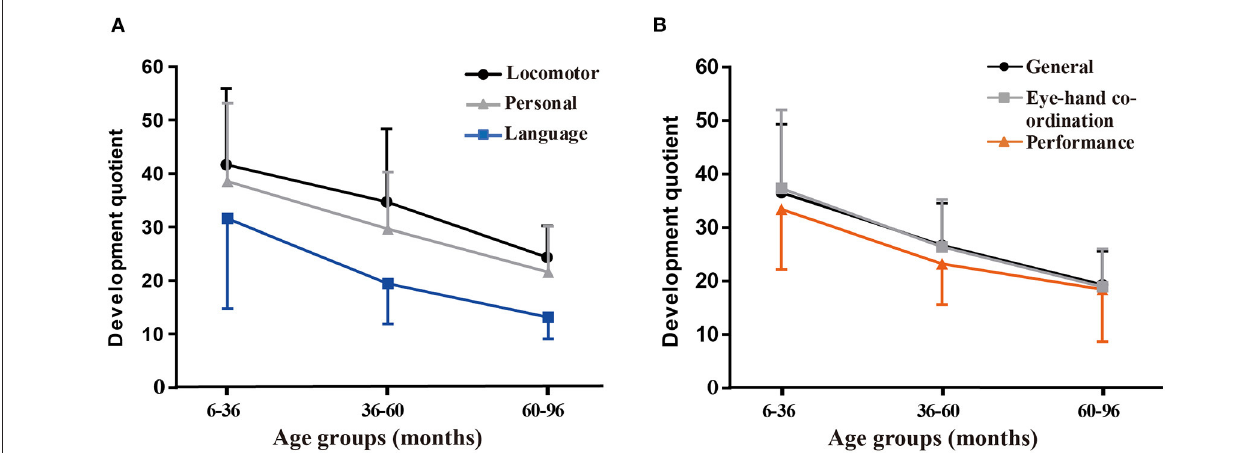
FIGURE 2 | Variations in the mean general quotients (GQs) and quotients for the five subscales according to the age group. (A) Variations in the mean quotients for the locomotor, personal-social, and language subscales. (B) Variations in the mean GQs and quotients for hand-eye coordination and performance subscales.